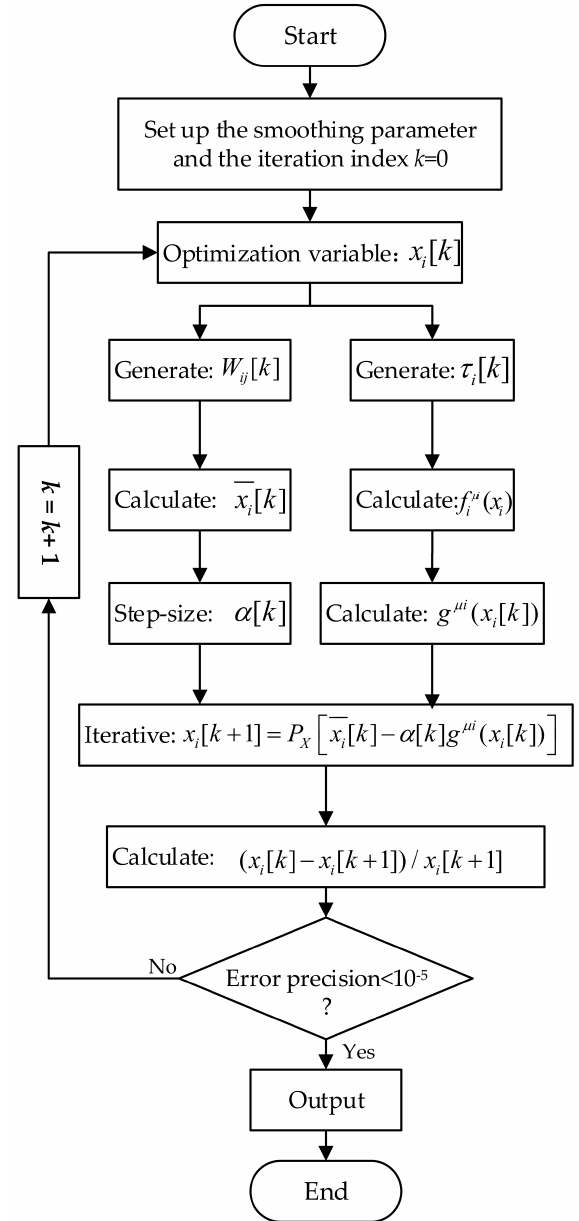
Figure 1. The flowchart of the distributed randomized gradient-free algorithm